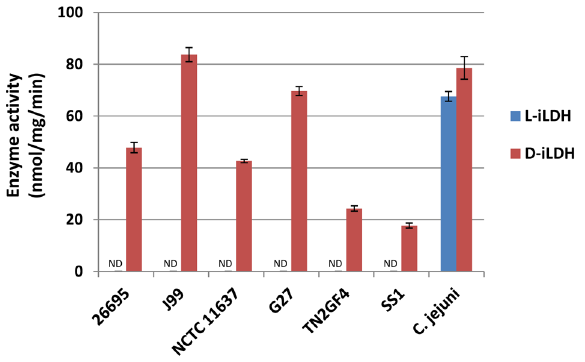
Figure 4. NAD-independent D- and L-lactate dehydrogenase (D- and L-iLDH) activities in cell extracts of H. pylori strains 26695, J99, NCTC 11637, G27, TN2GF4, SS1, and C.jejuni ATCC 33292. The activity was measured in cell extracts by a coupled colorimetric assay using 5 mM D- or L-lactate as an electron donor and a mixture of artificial acceptors, MTT and PMS. The activity in the first 30 min was spectrophotometrically monitored at 570 nm, and was normalized by the total protein concentration in cell extract. All the data represent the means 6 SD of three independent experiments.